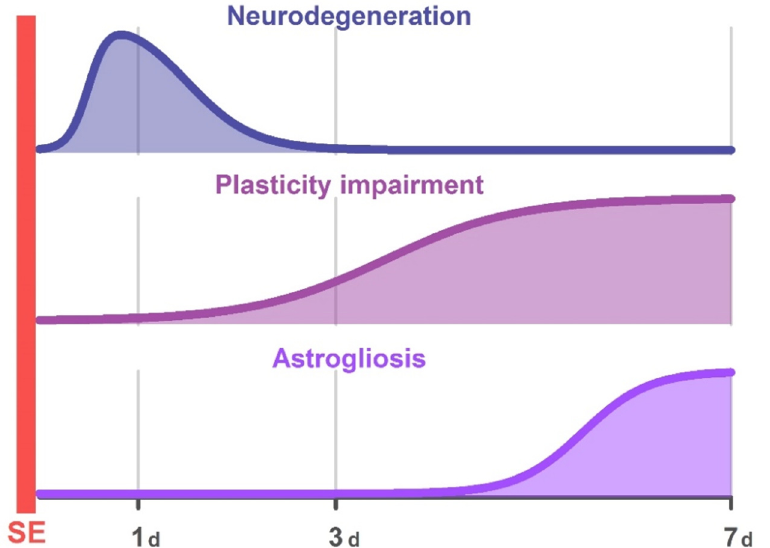
Figure 9. Main changes in the immature rat hippocampus followed pilocarpine-induced SE. The shaded area indicates periods when the differences between the control and post-SE groups were statistically significant. Abbreviations: SE—status epilepticus, d—day after SE.